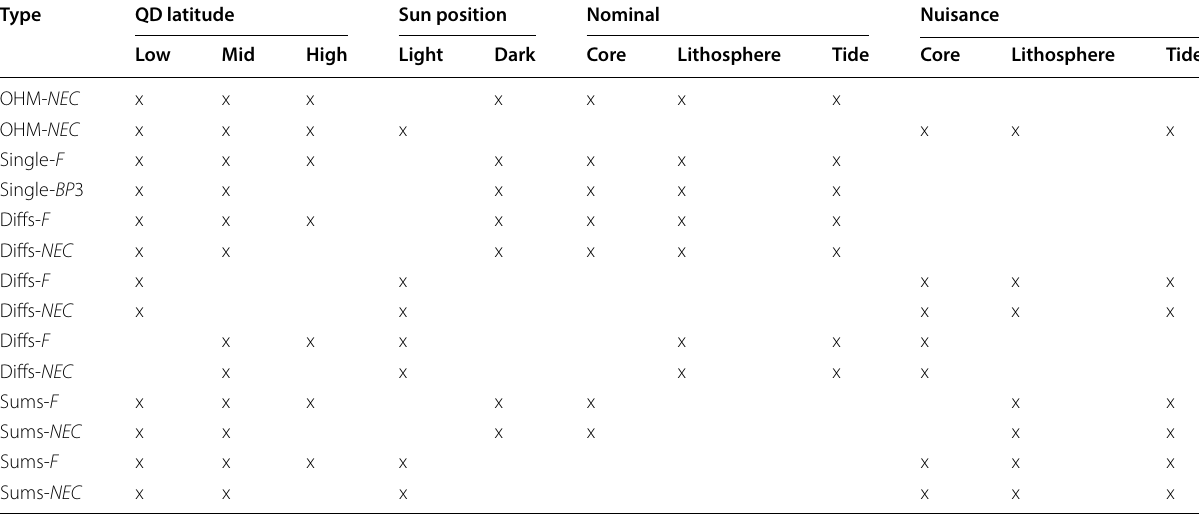
Table 3 CIY4 SIVW application, where the “x” indicate the QD latitude and sun position of the data type and which parameters it directly influences